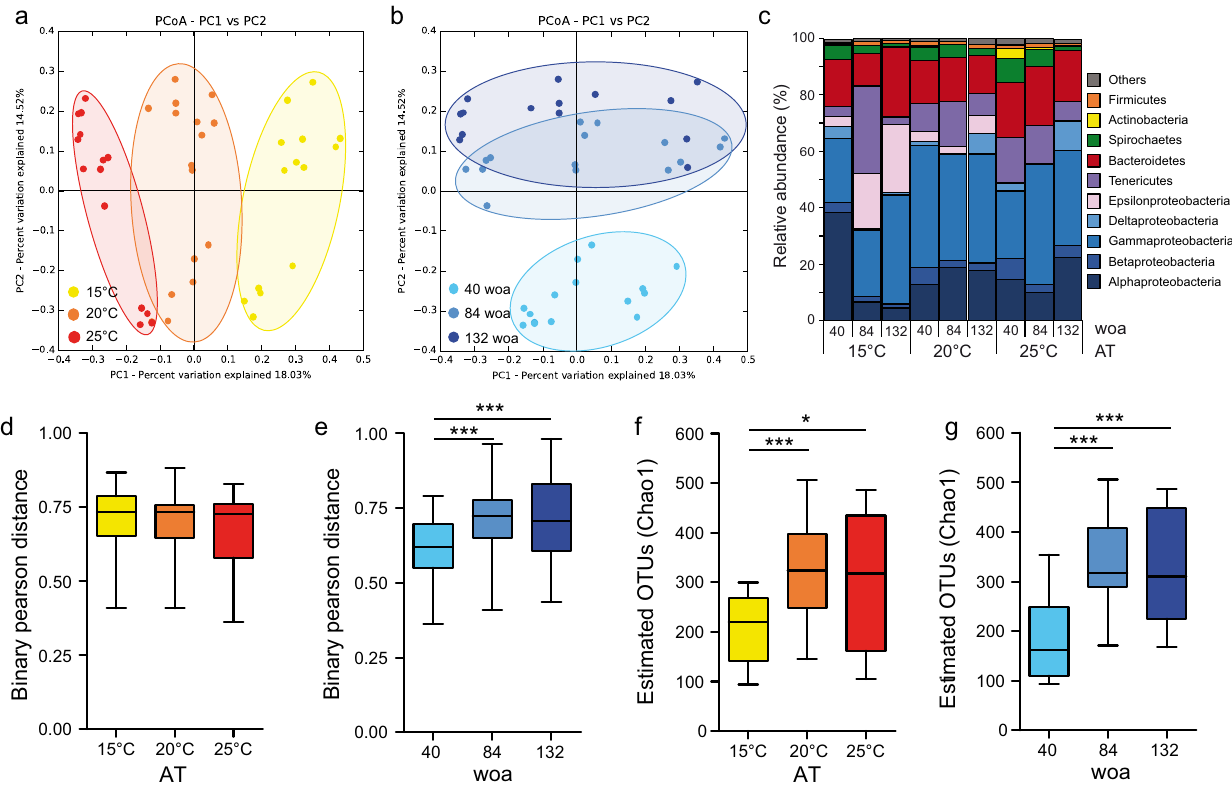
Fig. 3 Bacterial community changes in response to thermal acclimation. a PCoA (based on the binary-Pearson metric, sampling depth = 3600) illustrating similarity of bacterial communities based on acclimation temperature (AT). b PCoA (based on Binary-Pearson metric, sampling depth = 3600) illustrating similarity of bacterial communities based on weeks of acclimation (woa). Note: in a and b the same data are plotted, but with different color codes. c Relative abundances of principal bacterial groups, the abundances were summarized under the relative higher taxonomic categories (classes and phyla) and reported as percentages of the total. d , e β -diversity distances within each AT ( d ) and within woa ( e ), statistical analyses were performed using a non-parametric Kruskal – Wallis test followed by Dunn´s post hoc comparisons e H = 43.66; *** p < 0.001. f α -diversity (Chao1) comparison by AT (max rarefaction depth = 3600), statistical analyses were performed using a non-parametric Kruskal – Wallis test followed by Dunn ’ s post hoc comparisons ( H = 9.801; * p = 0.011, *** p < 0.001). g α -diversity (Chao1) comparison by woa (max rarefaction depth = 3600), statistical analyses were performed by